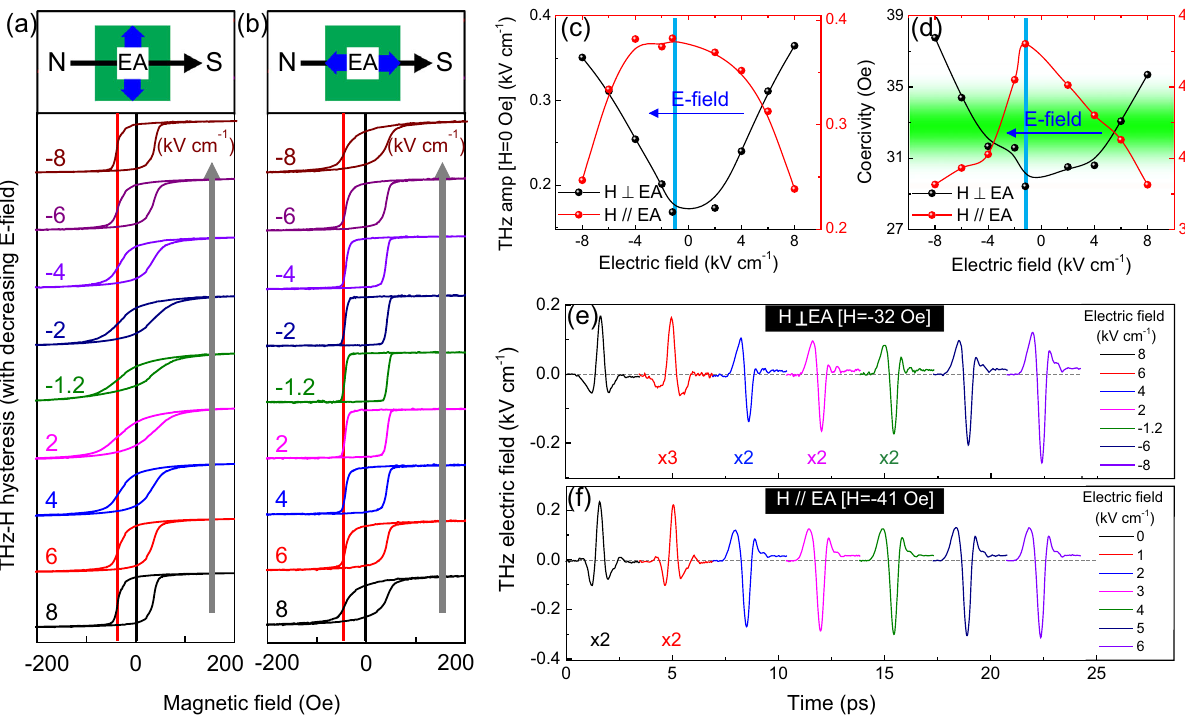
Fig. 3 Electric fi eld controlled phase reversal of THz spin current. a , b Gradual evolution of THz-H hysteresis in the device when electric fi eld is swept from 8 kV cm − 1 to − 8 kV cm − 1 at pump fl uence 0.4 mJ cm − 2 . The solid black line is depicted at the remnant magnetic fi eld, and the solid red line is depicted at the switching magnetic fi eld. The results are observed when the applied magnetic fi eld is a perpendicular to the easy axis of the FM layer, b parallel to the easy axis of the FM layer. c One-to-one comparison of the remnant magnetization of the FM layer for H ⊥ EA (Black balls and solid black line) and H// EA (Red balls and solid red line). d One-to-one comparison of the coercivity of the FM layer for H ⊥ EA (Black spheres and solid black line) and H// EA (Red spheres and solid red line). The area highlighted in the green shows the region of interest for accessing the THz phase reversal. e , f Sequential change in the THz phase upon the applied electric fi eld on the device when e H ⊥ EA; H = − 32 Oe f H// EA; H = − 41 Oe. e , f The pulses are shifted in the x -axis to show the applied electric- fi eld dependent phase reversal of the emitted THz